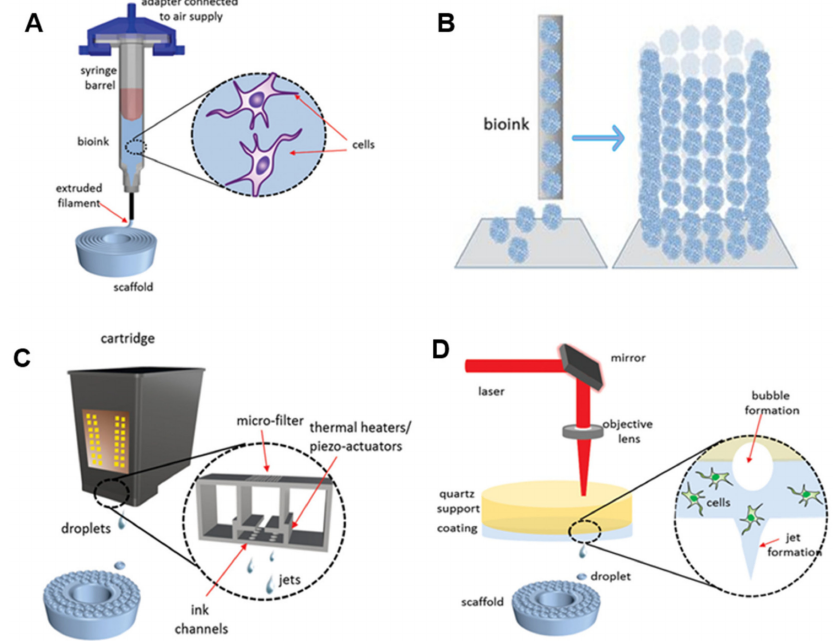
Figure 3. Modalities for bioprinting technologies. ( A ) Extrusion-based bioprinting. ( B ) Scaffold-free bioprinting. ( C ) Inkjet bioprinting. ( D ) Laser-induced forward transfer bioprinting (adapted from [32] with